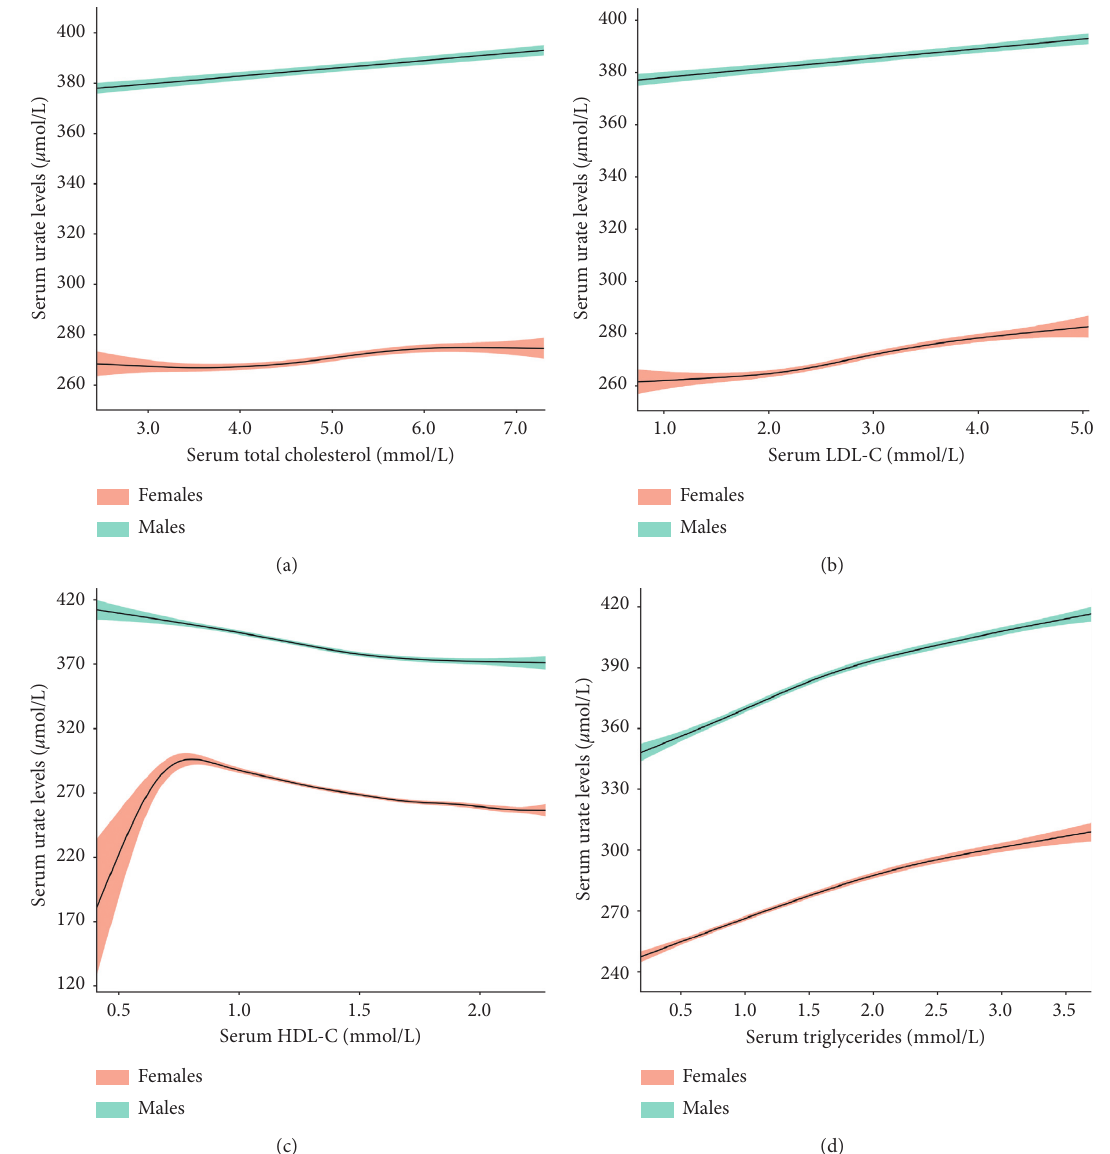
Figure 1: The fitted smoothing curves with 95% confidence intervals for lipid profiles and serum urate level after adjustment for age, body mass index, and estimated glomerular filtration rate. (a) Total cholesterol, (b) LDL-C, (c) HDL-C, and (d) triglycerides. LDL-C: low-density lipoprotein cholesterol; HDL-C: high-density lipoprotein